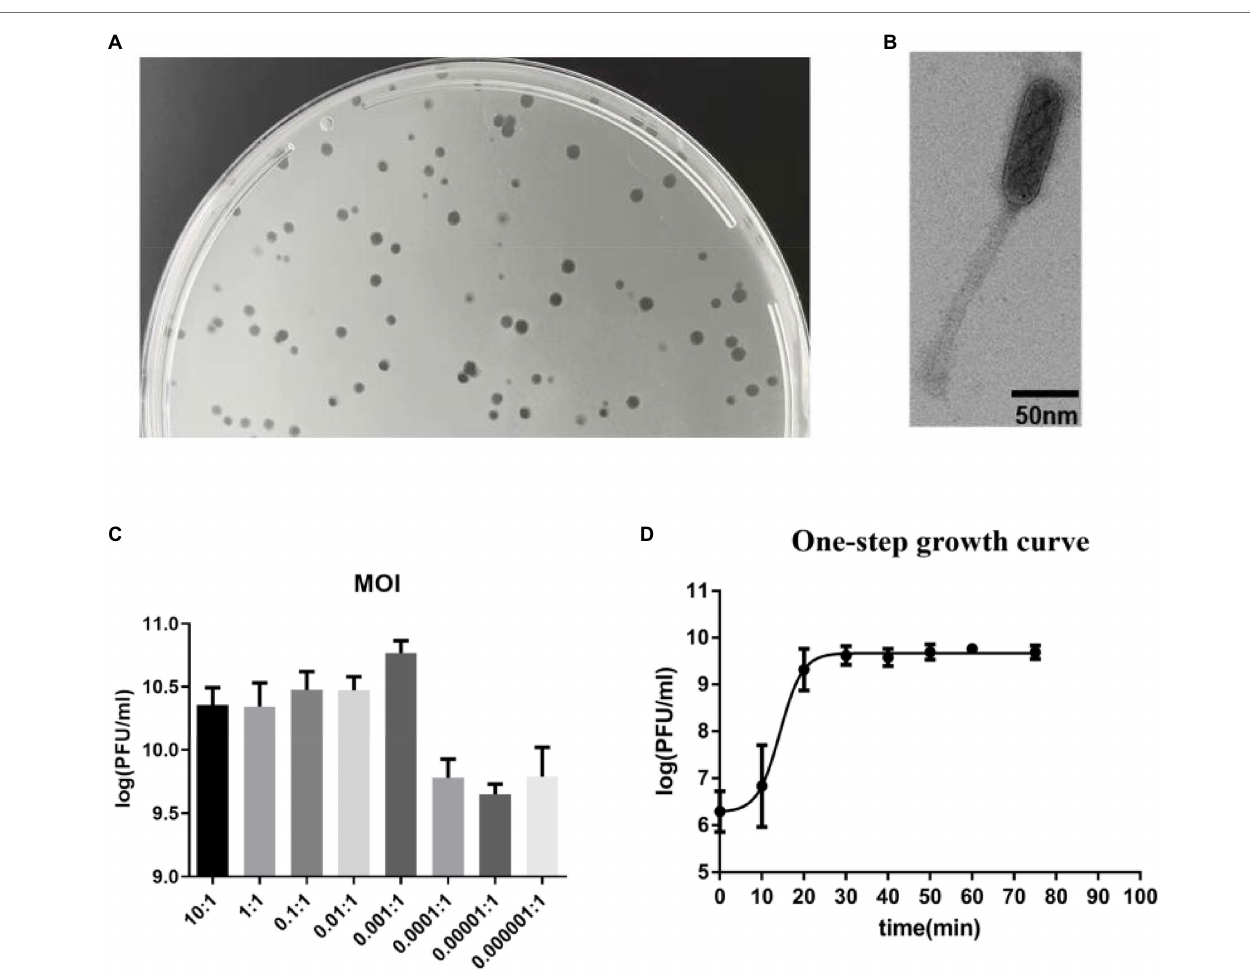
FIGURE 1 | Biological characterization of E. faecalis phage vB_EfaS_efap05-1. (A) Phage efap05-1 forms clear plaques on the agar plate. (B) The transmission electron micrograph reveals that efap05-1 is a Saphexavirus which is a member of Siphoviridae. (C) The optimal MOI of phage efap05-1 is 0.001. (D) The one-step growth curve of